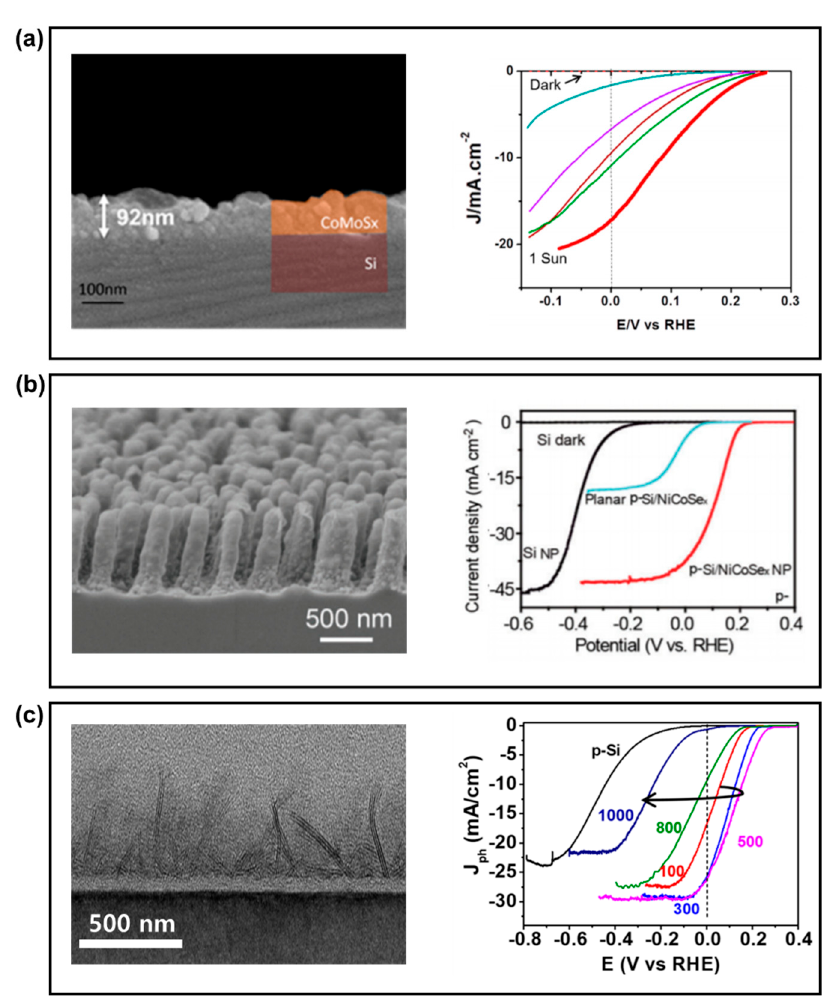
Figure 15. Experimental reports on multi-/mixed-phase TM(D)C co-catalysts on silicon. ( a ) Cross-section view taken by scanning electron microscope (SEM) (left) and characterizations of the Si/a-CoMoS x electrode with a catalyst loading (right), the PEC current density (J) verses voltage (V) plots. Adapted from reference [94]. Copyright (2015) American Chemical Society. ( b ) SEM image of p-Si/NiCoSe x nanoparticle (NP) array-nanopillars (left) and the corresponding PEC current density verses potential plots (right). Adapted from reference. [93] with permission from The Royal Society of Chemistry. ( c ) Cross-section transmission electron microscope (TEM) image of Mixed-phase (1T and 2H) MoS 2 on p- Si photocathode(left) and the corresponding J-V characteristics with different thickness of MoS 2 layer(right) the number of ALD cycle for MoS 2 deposition is denoted in different color. Adapted from reference [53].